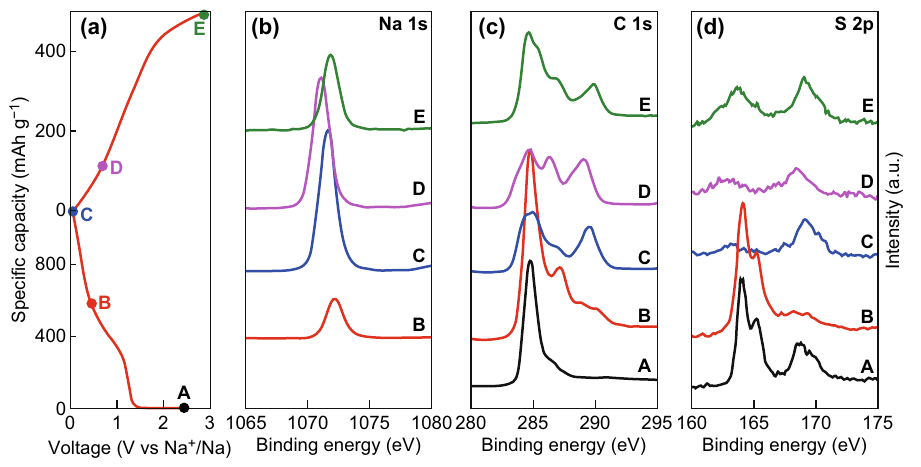
Fig. 6 Ex situ XPS profiles of SC-800 in different states during the initial charge/discharge cycle: a corresponding voltage states; b Na 1s, c C 1s, and d S 2p XPS